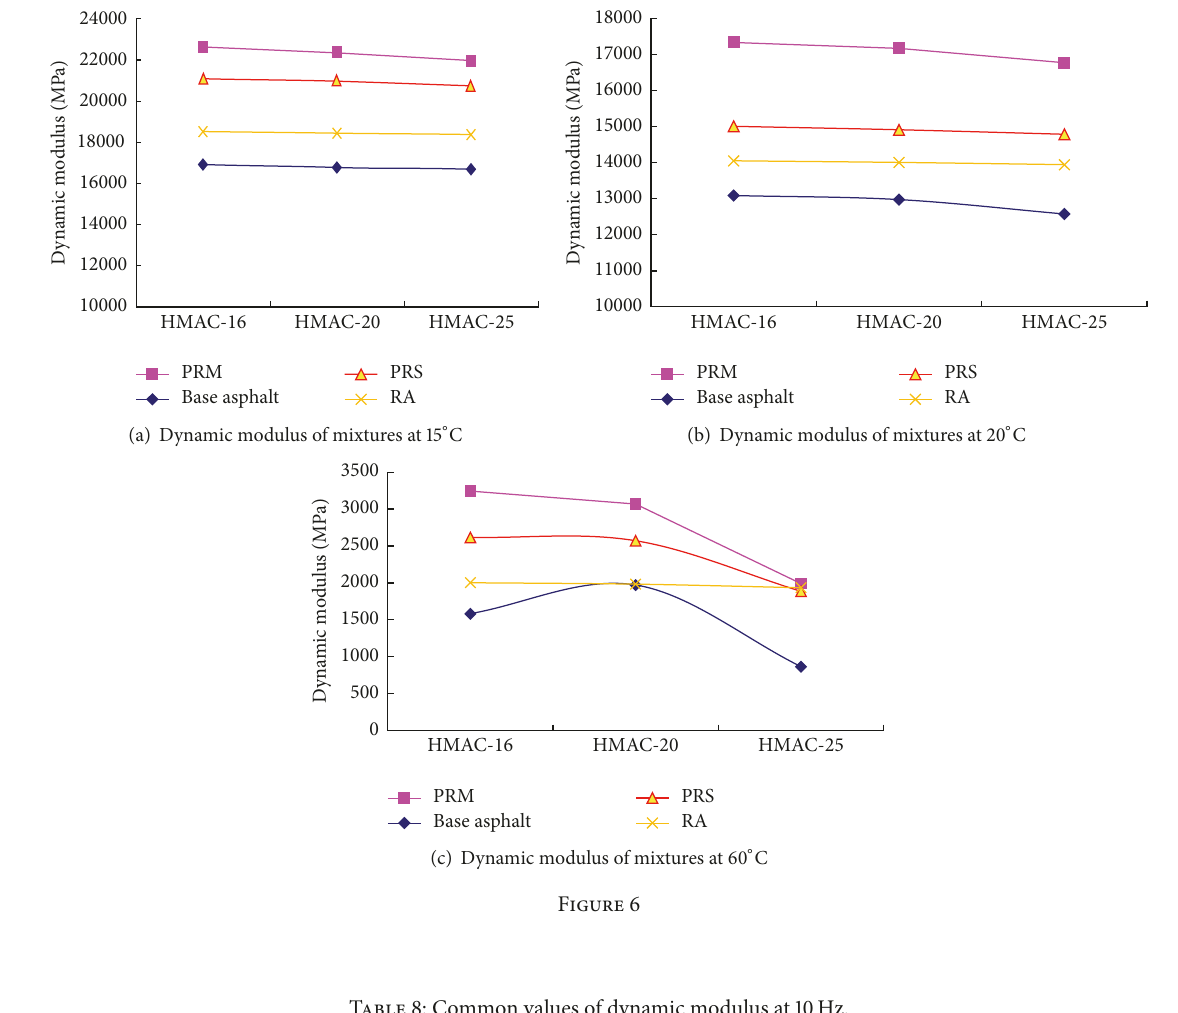
Table 8: Common values of dynamic modulus at